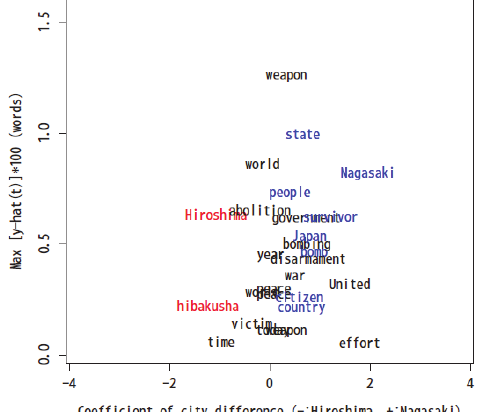
Fig. 8. Scatter plot of keyword's frequency by cluster in 1977